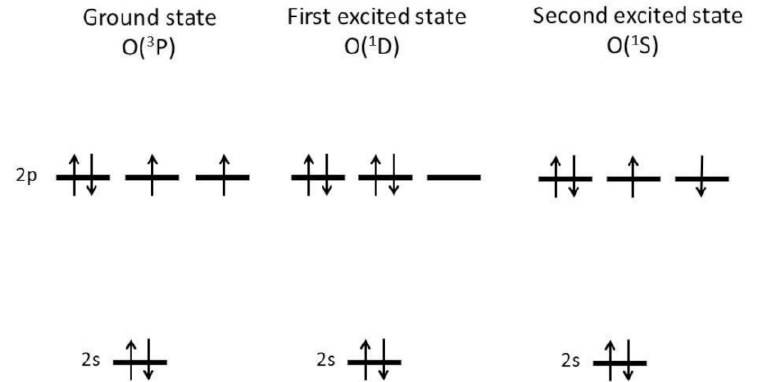
Figure 9. Electronic configurations of ground state, first excited state, and second excited state of the oxygen atom [109]. Two electrons in the 1s state are omitted. Copyright 2016, with permission from